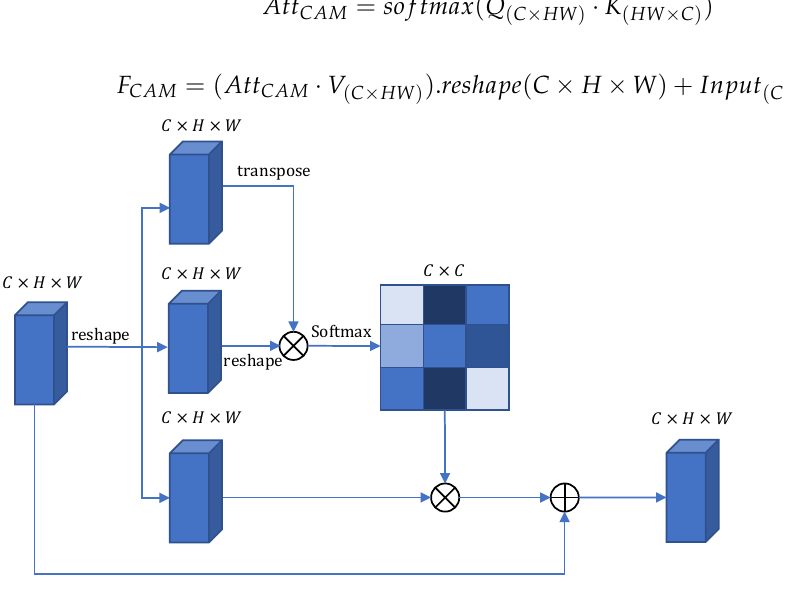
Figure 6. Illustration of the structure of CAM.